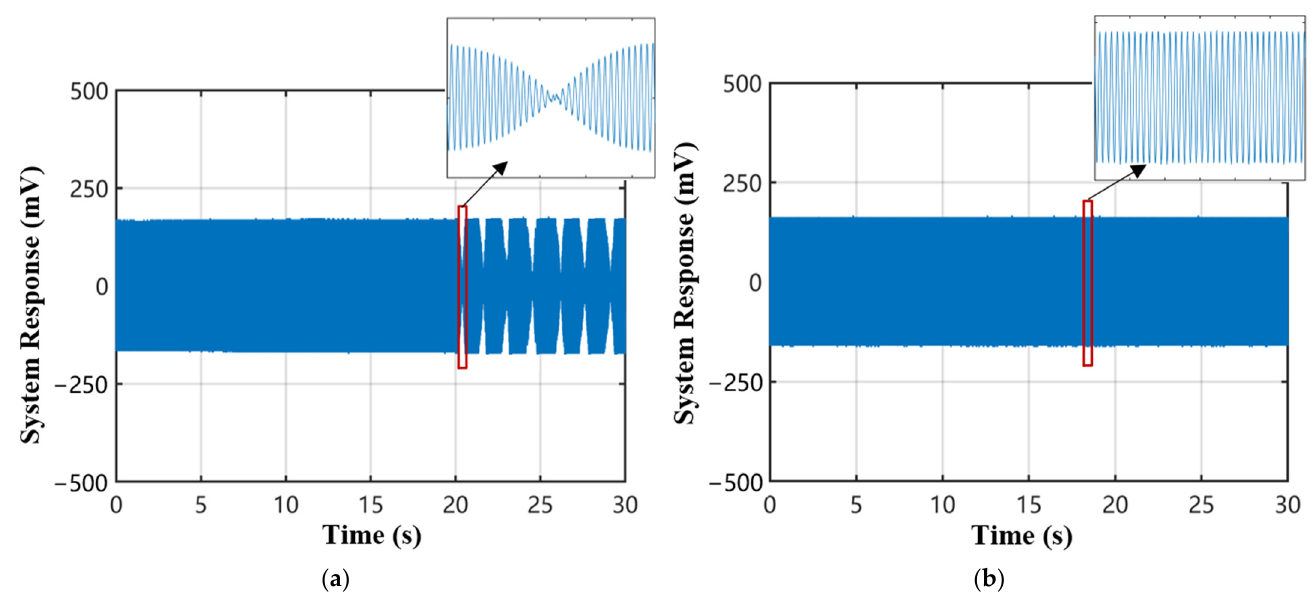
Figure 10. Demodulated signal before and after topology improvement of sensing system. ( a ) Demodulated signal before improvement. ( b ) Demodulated signal after improvement.